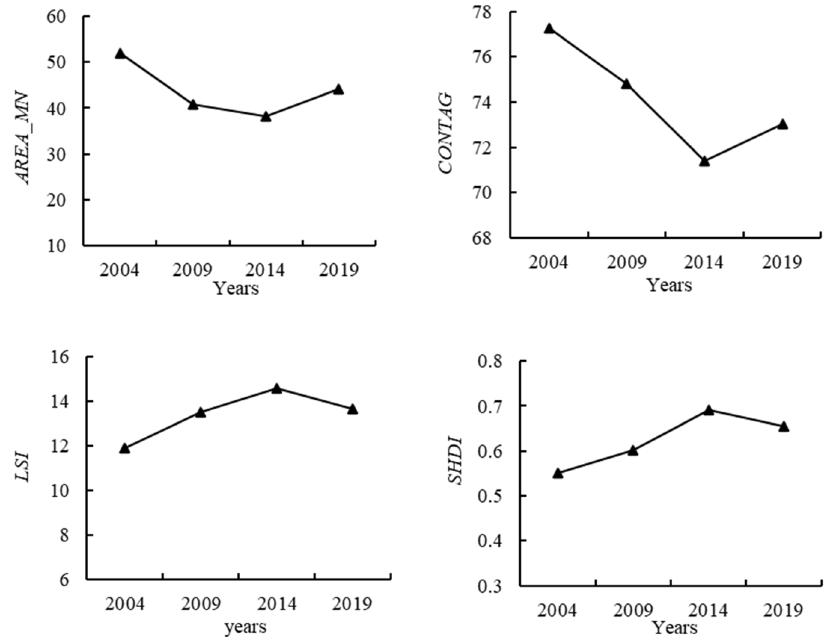
Figure 3. The change of landscape pattern during 2004–2019.